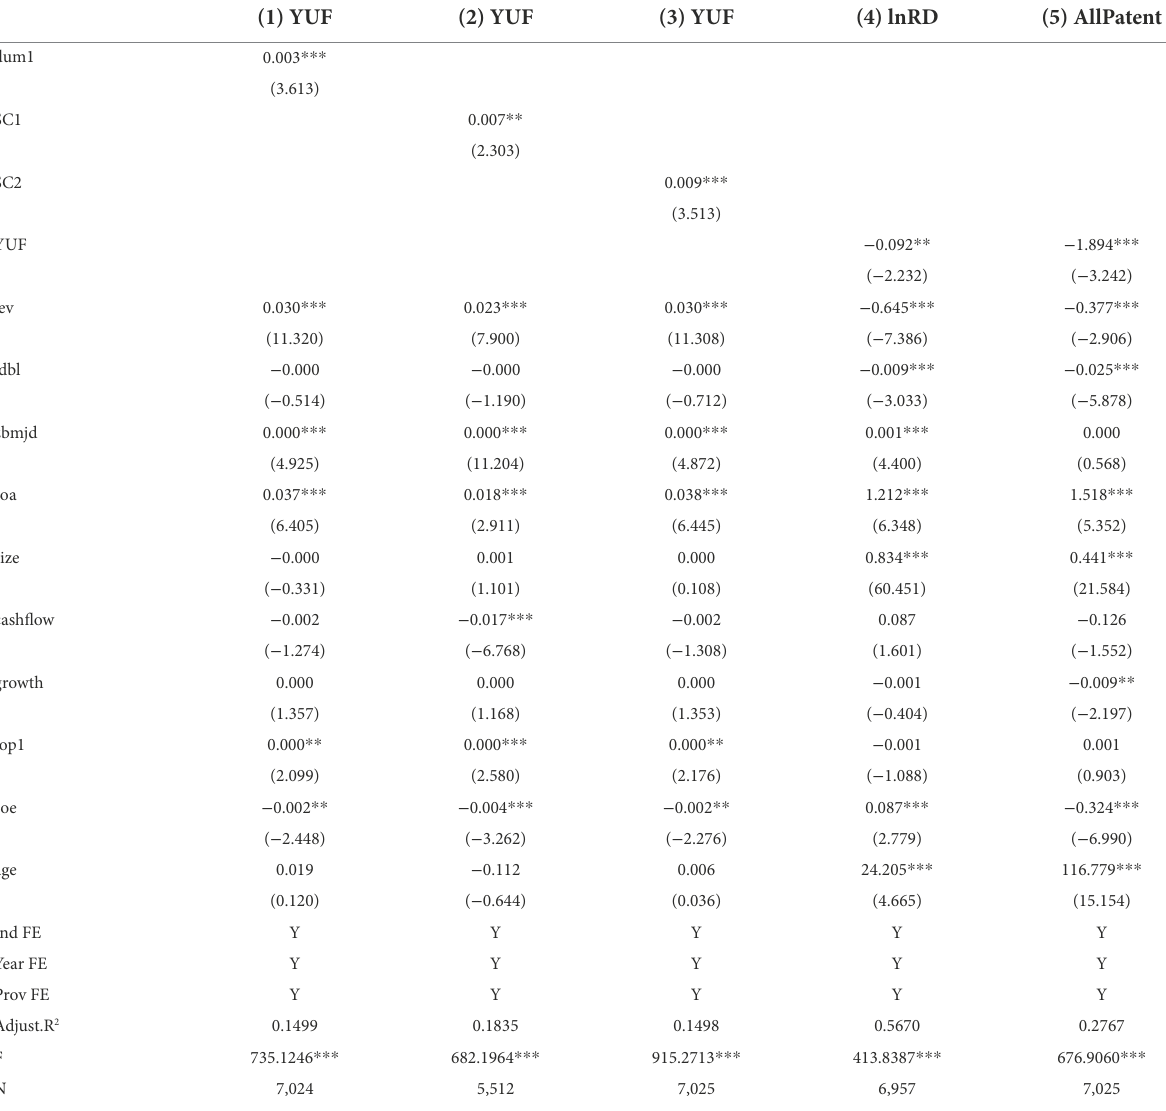
TABLE 11 Resource occupied